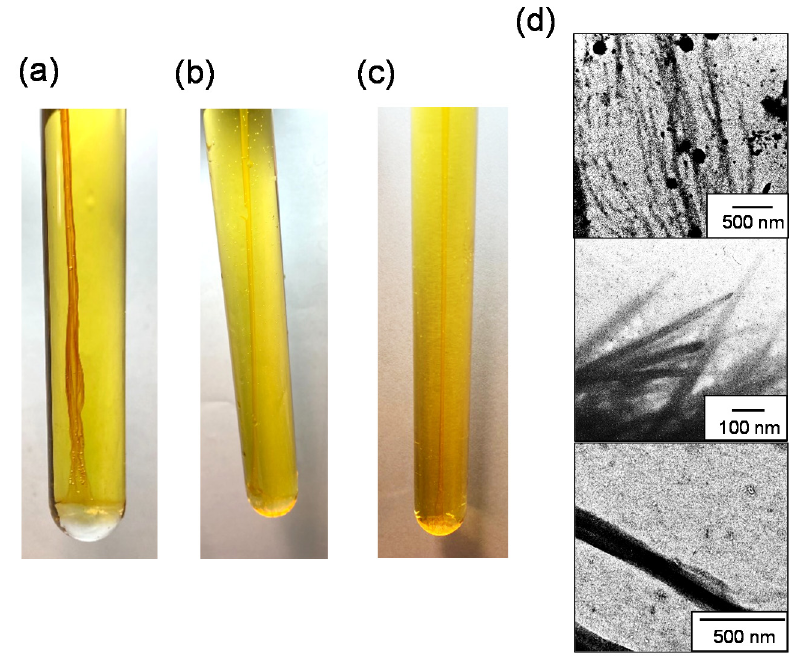
Figure 5. Photographs of gels produced upon addition of NMP solutions of ( a ) 11 wt%, ( b ) 8 wt%, and ( c ) 6 wt% of HPMC ― 4 (0.2 mL) to 4 mM aqueous solutions of Pd II ions (20 mL). ( d ) TEM images